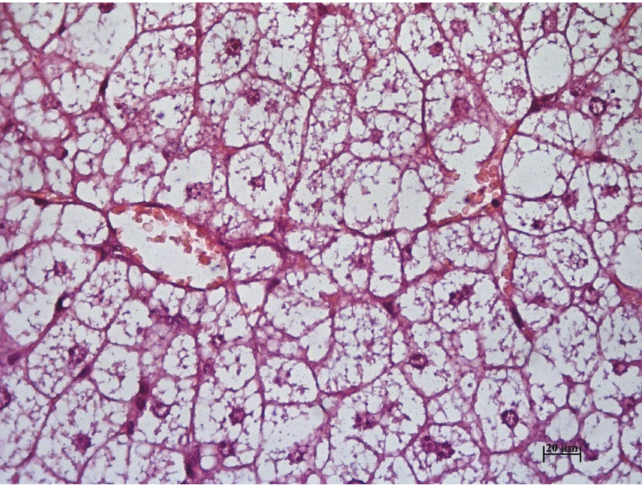
Figure 9. Microphotograph of the liver treated by compound 2e after 4 weeks of the experiment. Total fatty hepatosis, cytolysis of hepatocytes. Hematoxylin and eosin staining, ×